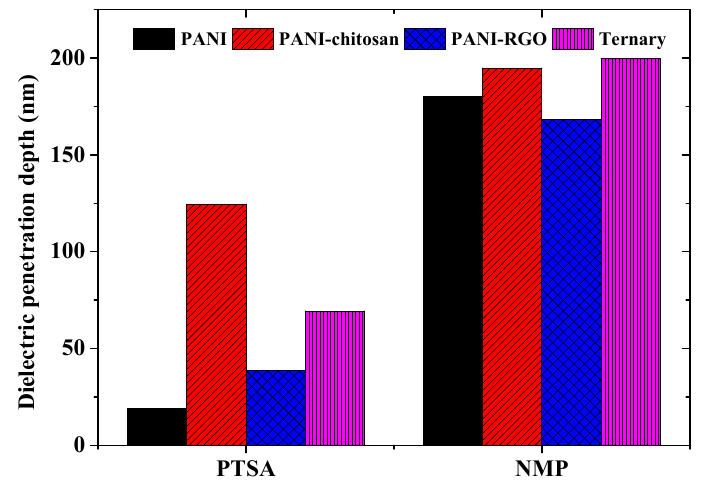
Figure 6. Penetration depths through a dielectric medium for PTSA and NMP-based samples .